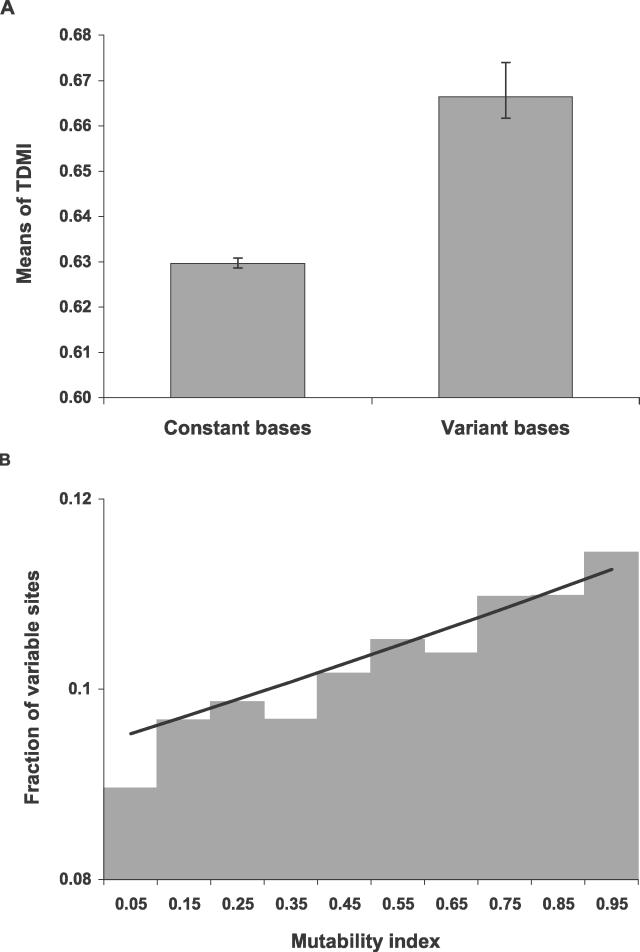
Relationship between TDMIs of L4 Sites and Their Variation during E. coli MG1655 and E. coli CFT073 Divergence(A) This graph represents average TDMI at constant and variable L4 sites in gene by gene alignment of the completely sequenced strains E. coli CFT073 and E. coli MG1655. In both genomic contexts, averages of TDMI of constant sites are exactly the same: 0.630. For the variable sites, averages of TDMI are 0.668 for MG1655 and 0.665 for CFT073. The error bars are 95% CIs on the mean estimated by bootstrap.(B) This graph represents the fraction of variable L4 sites as a function of TDMI (histogram) and logistic regression (p < 2 × 10−16, n = 550,575) (line).